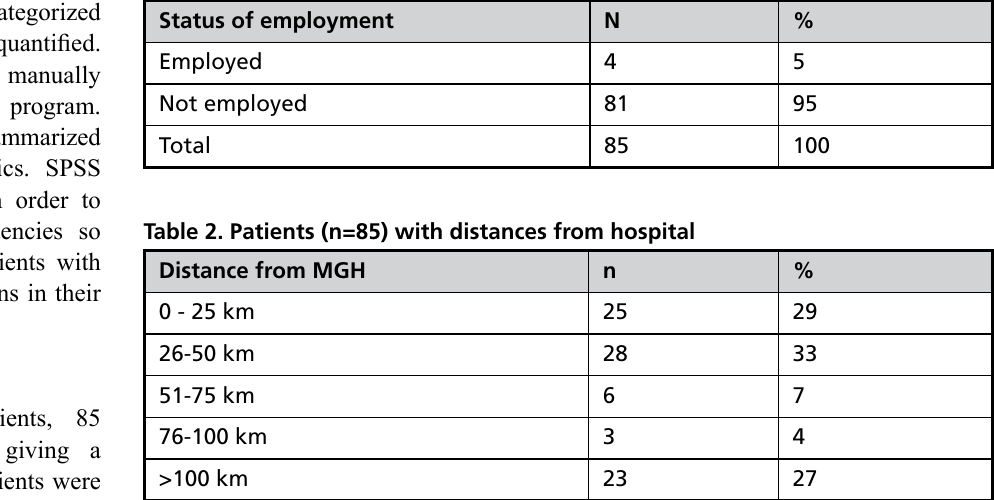
table 1: employment status of patients (n=85)